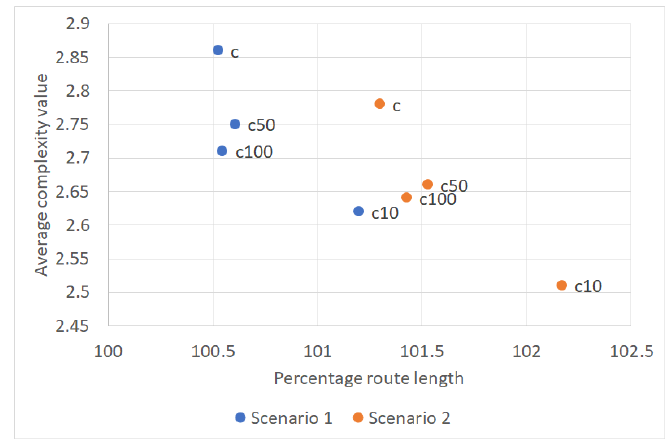
(cid:16) (cid:17) = 0 (c) and denominator 10, 50, 100 (c10, c50, r part